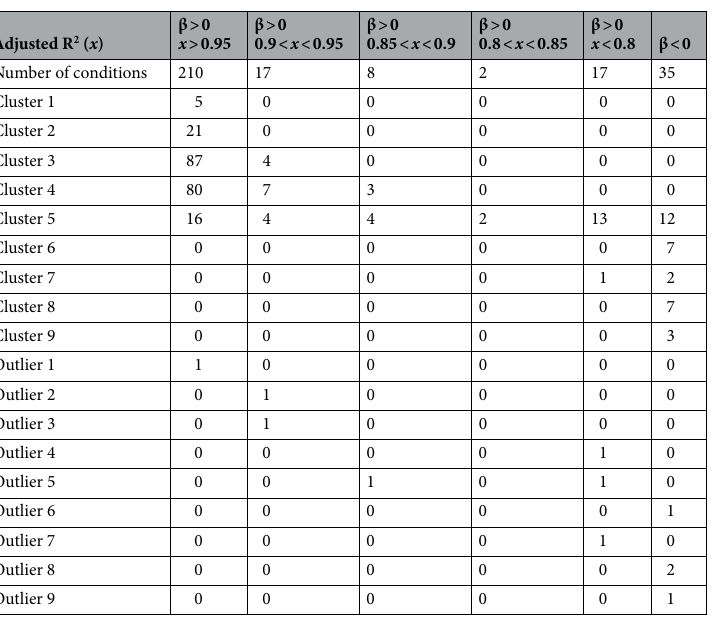
Table 2. The number of conditions in each age-related and outlier cluster for different thresholds of adjusted R 2 (x) (with a positive β (coefficient of the age variable) in the Gompertz model), and the number of conditions with a negative β.